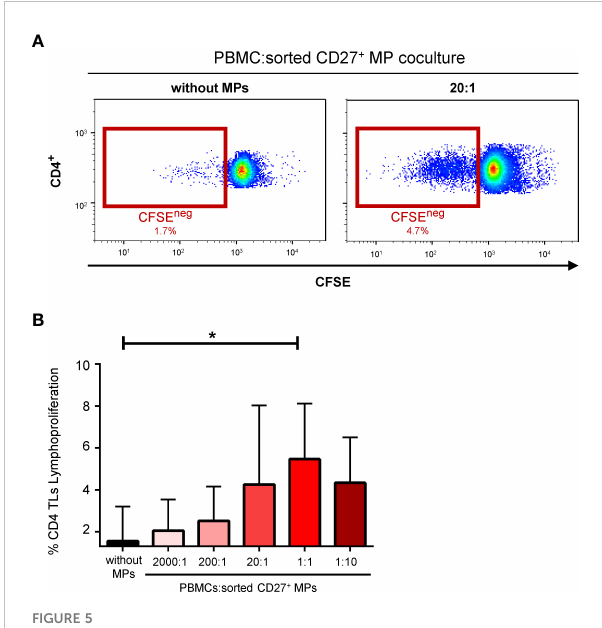
FIGURE 5 Effect of CD27 + MPs on CD4 + TL lymphoproliferation. (A) Representative FACS plots measuring the proliferation of CD4 + TLs over a period of six days in seven coculture experiments corresponding to seven HDs (PBMCs were stained with anti-CD4 and anti-CD3 antibodies; CD4 + TLs were de fi ned as having a CD3 + CD4 + phenotype). This functional assay was also performed with various proportions of sorted CD27 + MPs. (B) Percentage of CD4 + TLs proliferating, for different ratios of PBMCs:sorted CD27 + MPs. The P values were obtained in ANOVA and Kruskal-Wallis post hoc tests: * P <